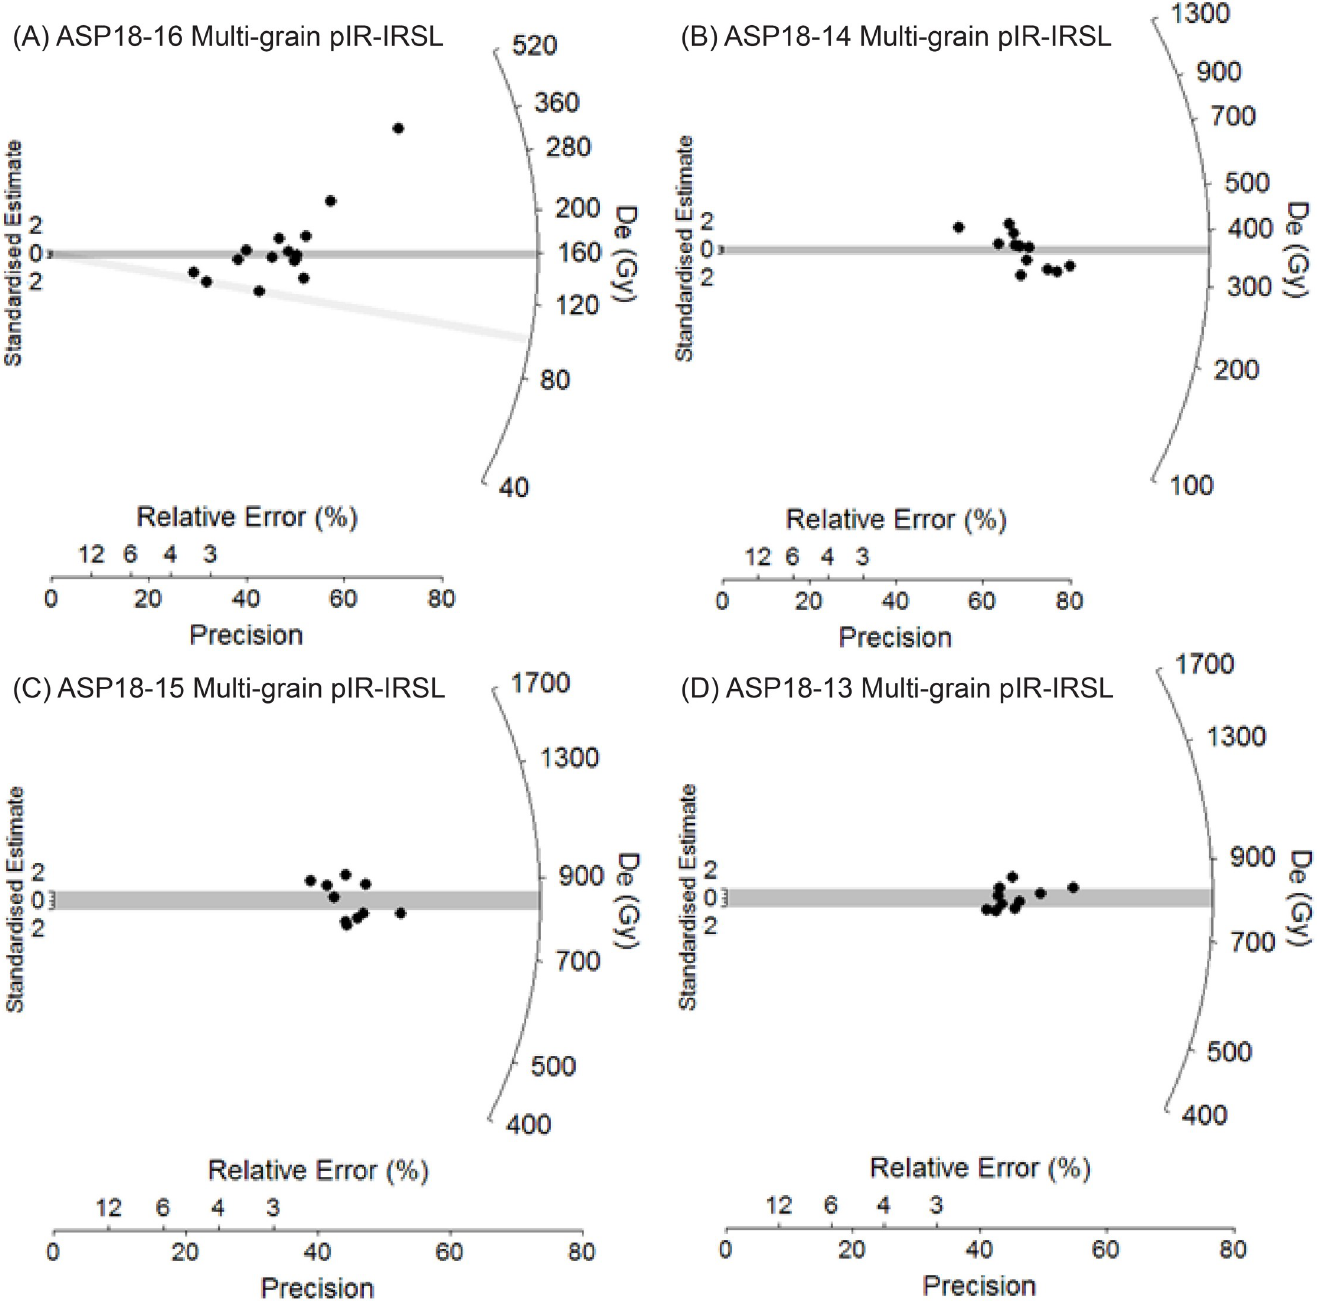
Fig 7. Multiple-grain pIR-IRSL D e distributions for the Area 1 luminescence dating samples, shown as radial plots. The shaded bands are centred on the D e values used for the age calculations, which were derived using either the 3-parameter minimum age model (light grey band sample ASP18-16) or the central age model (dark grey bands samples ASP18-14, ASP18-15, ASP18-13, ASP18-16) of Galbraith et al. [102]. single-grain TT-OSL D datasets also do not display prominent leading-edges of low D e or elongated tails of higher D values, and are not considered to be significantly positively e skewed according to the weighted skewness test outlined by Bailey and Arnold [130] and Arnold and Roberts [129]. Taken together, these single-grain TT-OSL and pIR-IRSL D